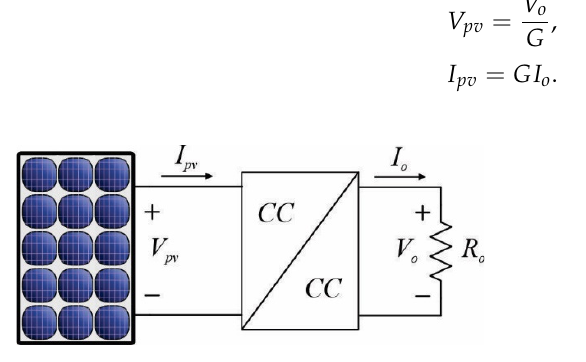
Figure 3. DC-DC converter applied as MPPT.